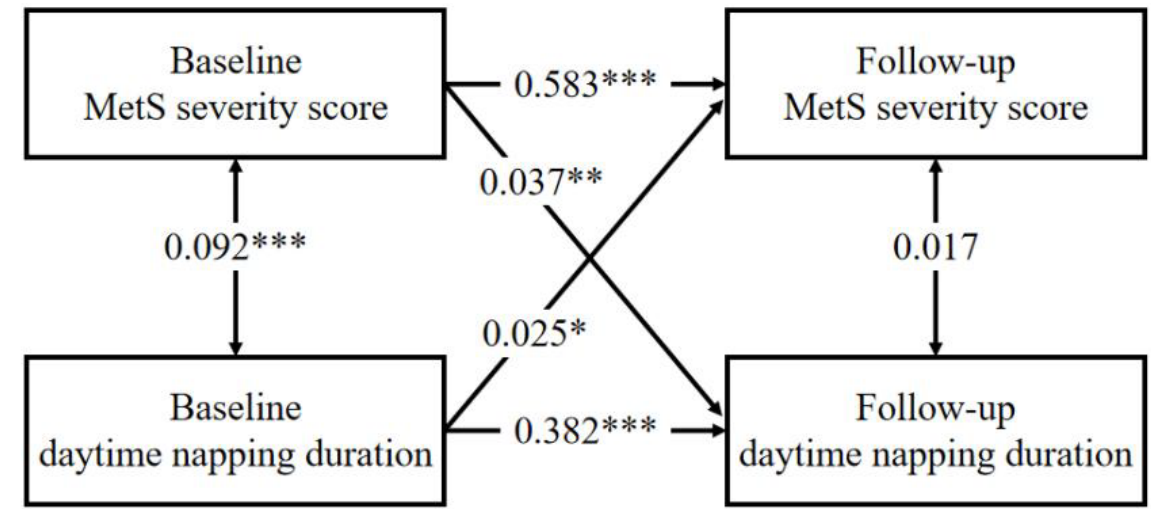
Figure 3. A cross-lagged panel analyses of MetS severity score and daytime napping duration at baseline and follow-up. Abbreviation: MetS severity score, the number of metabolic syndrome components. adjusted for: age, gender, living residence, marital status, educational level, smoking status, drinking status, depressive symptoms, night-time sleep quality, night-time sleep duration, serum uric acid, LDL-C, and hsCRP. Correlations are represented via double-headed arrows and regressive paths via single headed arrows. * p < 0.05; **, p < 0.01; ***, p < 0.001.